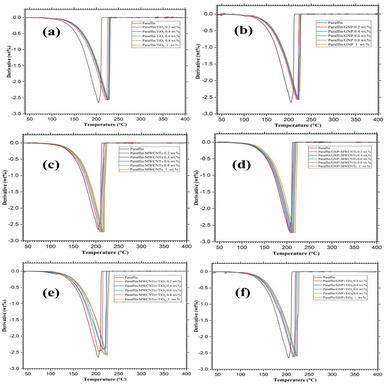
DTG curves of single and hybrid nano enhanced PCMs (a) PAR + TiO2, (b) PAR + GNP, (c) PAR + MWCNTs, (d) PAR/MWCNTs + GNP, (e) PAR/MWCNTs + TiO2, and (f) PAR/GNP + TiO2.